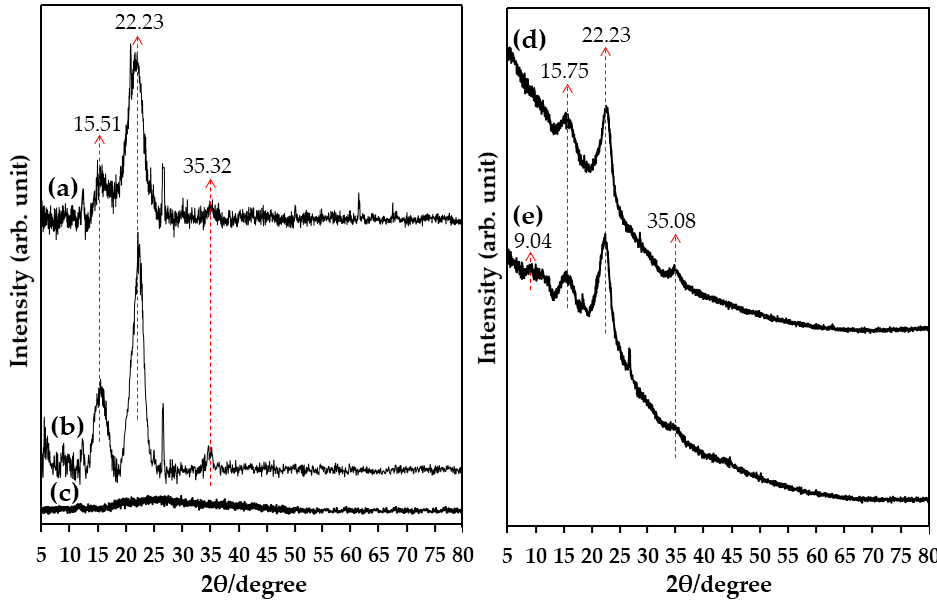
Figure 1. XRD spectra of ( a ) rice straw waste, ( b ) CF, ( c ) CS NPs, ( d ) CS-CF BNCs, ( e ) CS-CF/5FU